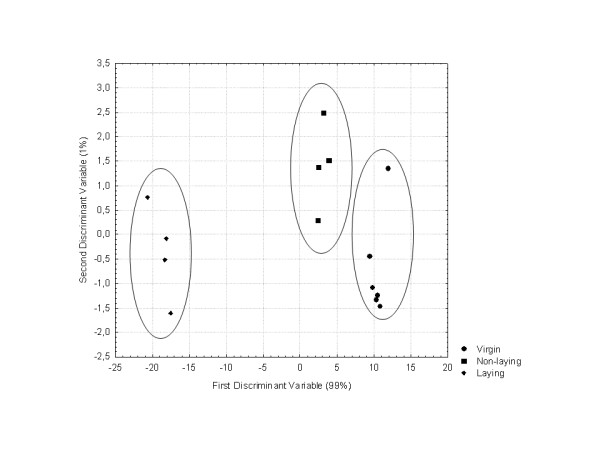
Queen Pheromone Profiles. Discriminant analysis of queen mandibular gland chemical profiles of virgins, mated, and laying queens. Chemical composition of the mandibular gland extracts of virgin, mated and laying queens were analysed using gas chromatography. Discriminant analysis of mandibular extract of queens was based on the relative proportion of the chemical compounds (F(18,6) = 28.44, p = 0.0002).